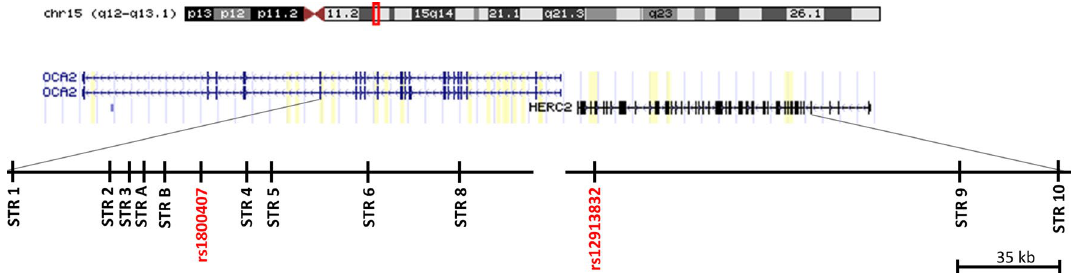
Figure 1. Position of STR markers included in this study relative to intron–exon structure of OCA2-HERC2 genes on chromosome 15 q12-q13.1. Two key SNPs for eye color prediction, rs1800407 and rs12913832 of the IrisPlex panel are also included.